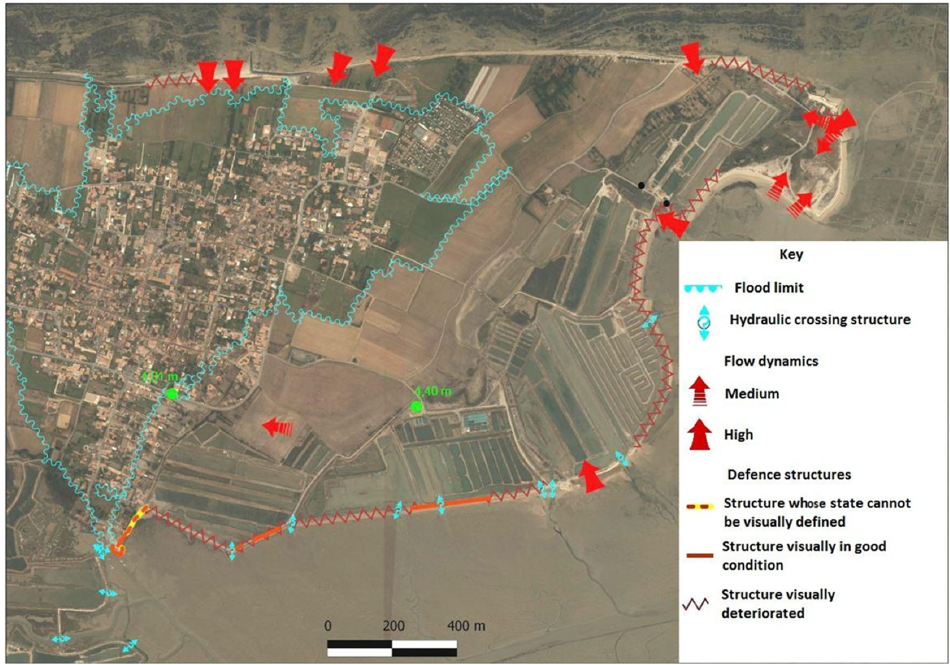
Figure 9. Synthesis map of Xynthia event.